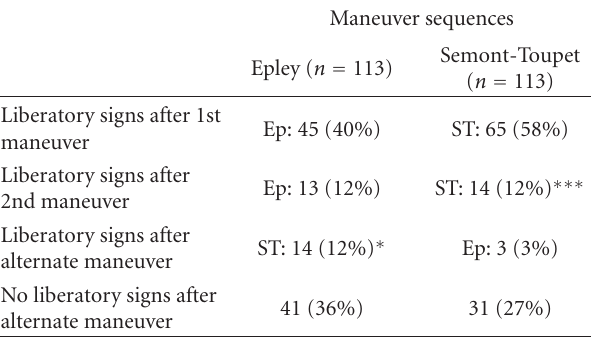
Table 2: Comparison of liberatory signs in Epley (Ep) and Semont- Toupet (ST) maneuver sequences. The sequence was stopped after vertigo and nystagmus. These signs more frequently observed after ST than after Ep (70% versus 51%, P < 0 . 001, Fisher’s exact test). ST as a 3rd maneuver also yielded a higher rate of liberatory signs than Ep (12%, versus 3%, P < 0 . 02, Fisher’s exact